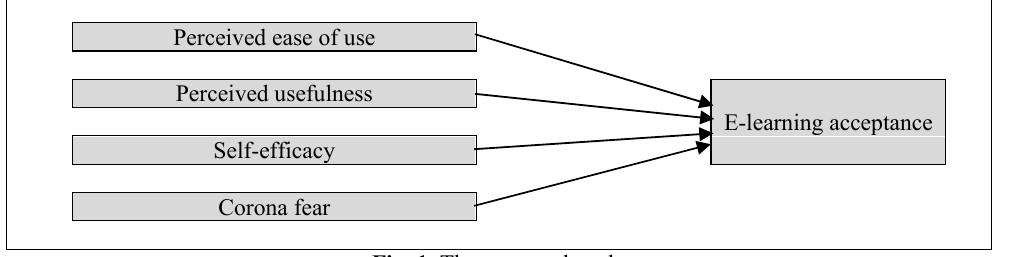
Fig. 1. The proposed